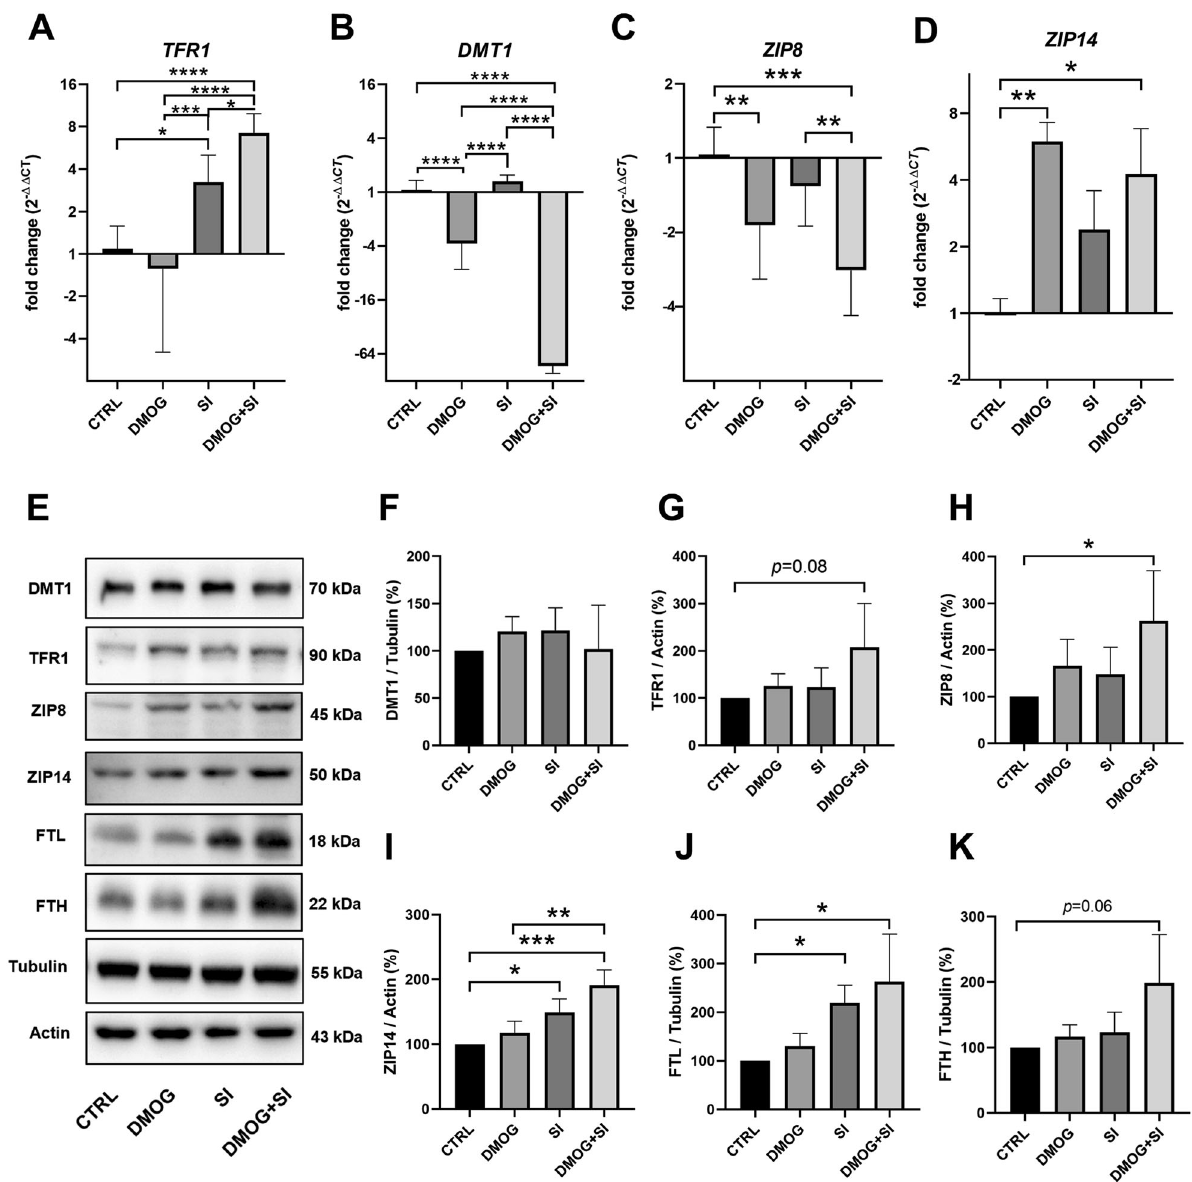
Fig. 4 Iron transporters involved in non-transferrin-bound Fe 2 + import were upregulated in DMOG + SI co-treated ARPE-19 cells. Transcript levels of A TFR1 were signi fi cantly upregulated and B DMT1 were signi fi cantly downregulated compared to all treatments. Gene expression of non-transferrin-bound iron importers C ZIP8 was signi fi cantly downregulated and D ZIP14 was upregulated by DMOG + SI co- treatment compared to controls. E – I Analysis of iron importers on protein level revealed that only ZIP8 and ZIP14 were signi fi cantly upregulated by DMOG + SI co-treatment. J The ferritin subunit FTL was signi fi cantly upregulated in SI- and DMOG + SI co-treated cells, while the other subunit FTH showed a trend towards upregulation in DMOG + SI co-treated cells ( K ). Data are presented as means + SD. Western blots (3 independent groups) and qRT-PCR (6 independent groups) were statistically analyzed with one-way ANOVA. * p < 0.05, ** p < 0.01, *** p < 0.001, and **** p <